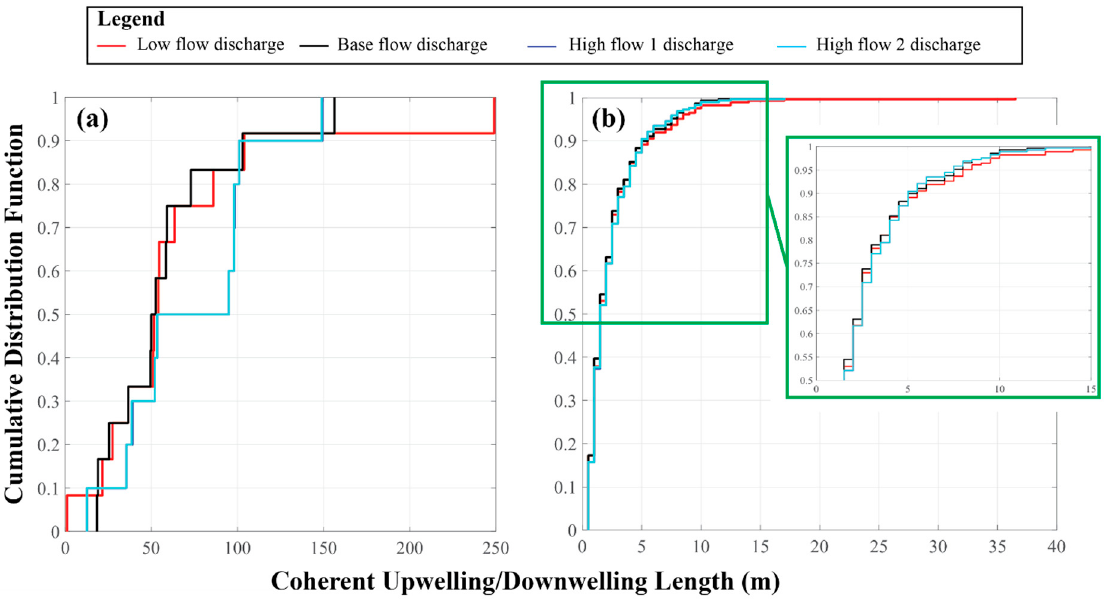
Figure 7. Cumulative distribution function of the length distribution of spatially coherent upwelling/downwelling stretches at the streambed interface under various flow discharges, assuming ( a ) constant intrinsic permeability ( k = 10 − 9 [m 2 ]) for the entire subsurface region, and ( b ) a decaying intrinsic permeability.